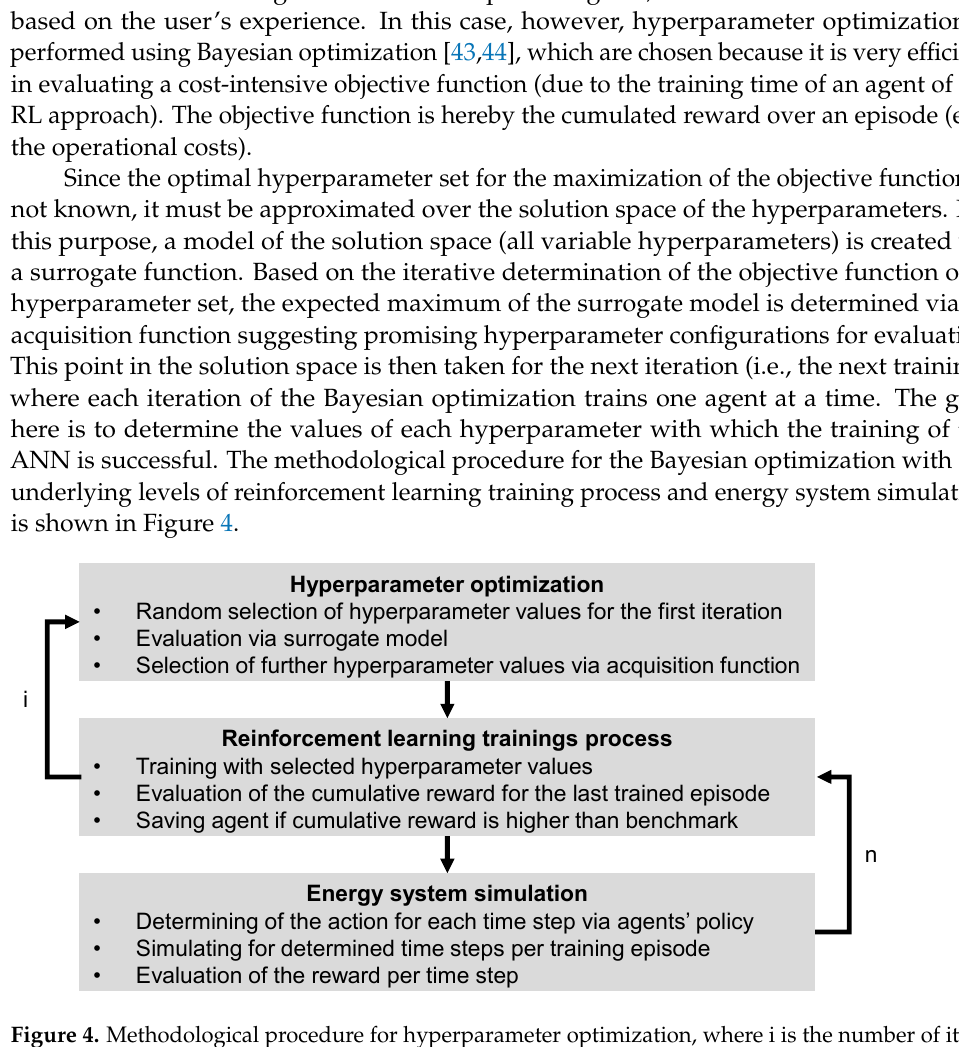
Figure 4. Methodological procedure for hyperparameter optimization, where i is the number of itera- tions for hyperparameter optimization and n is the number of training episodes of each reinforcement learning training